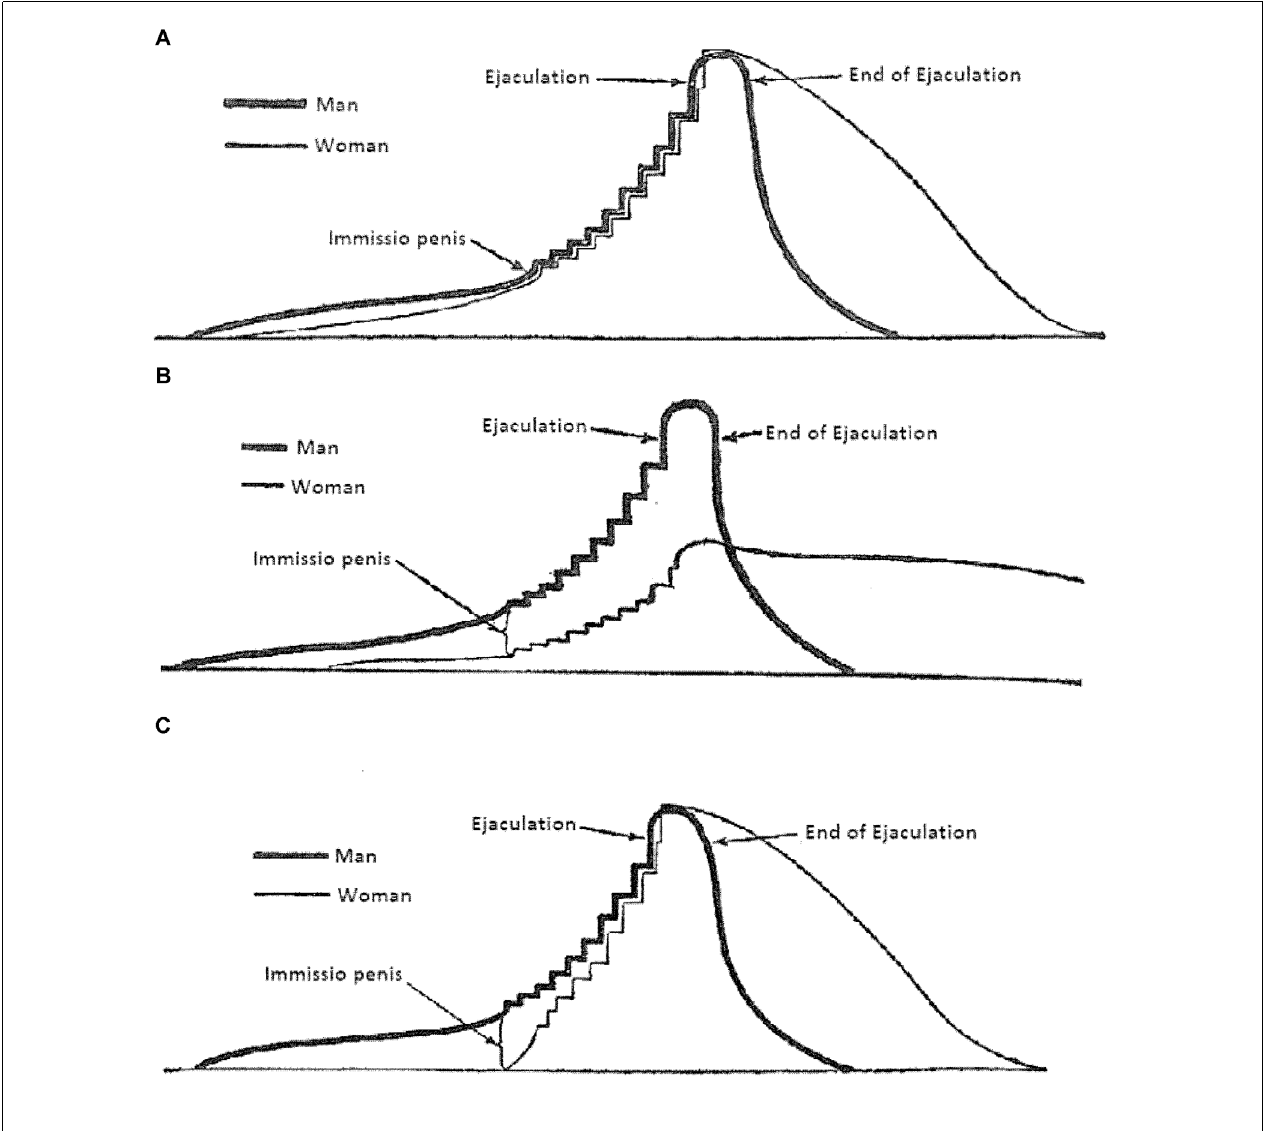
FIGURE 2 | van de Velde’s (1926) illustration of human coital interactions. (A) The changes in sexual excitation during an ideal copulatory encounter. With ideal it is understood that the man and the woman reache orgasm at the same time. Excitation is defined as the summation of sexual desire and pleasure, bodily and psychic. (B) Similar to panel (A) , but here the sexual interaction occurs with an inexperienced woman without adequate coital stimulation. (C) Similar to panel (A) , but now the woman is sexually experienced. The prelude was omitted, but the woman’s low initial excitation was compensated for by her experience. From van de Velde